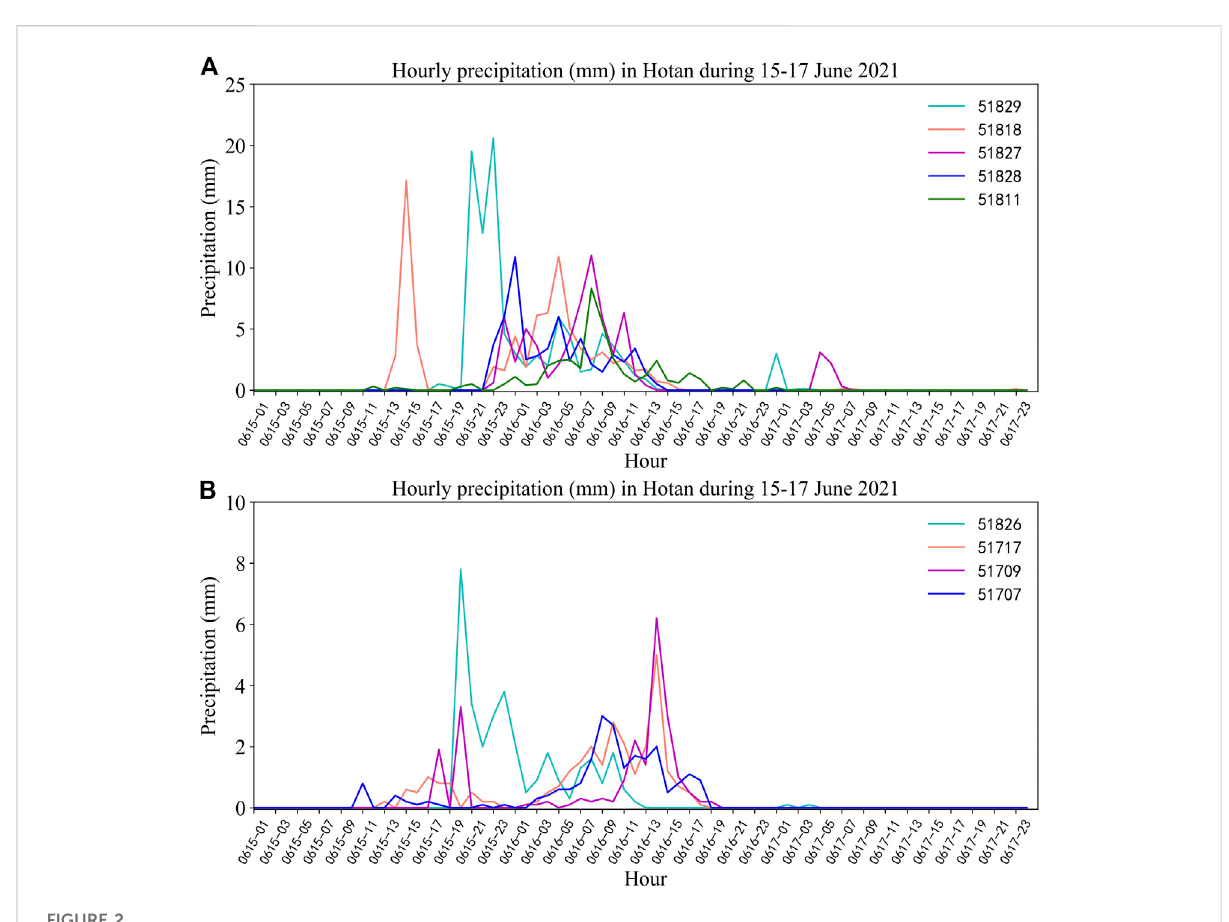
FIGURE 2 Hourly precipitation (mm) in Hotan during June 15 – 17, 2021 (A) ~ (B)